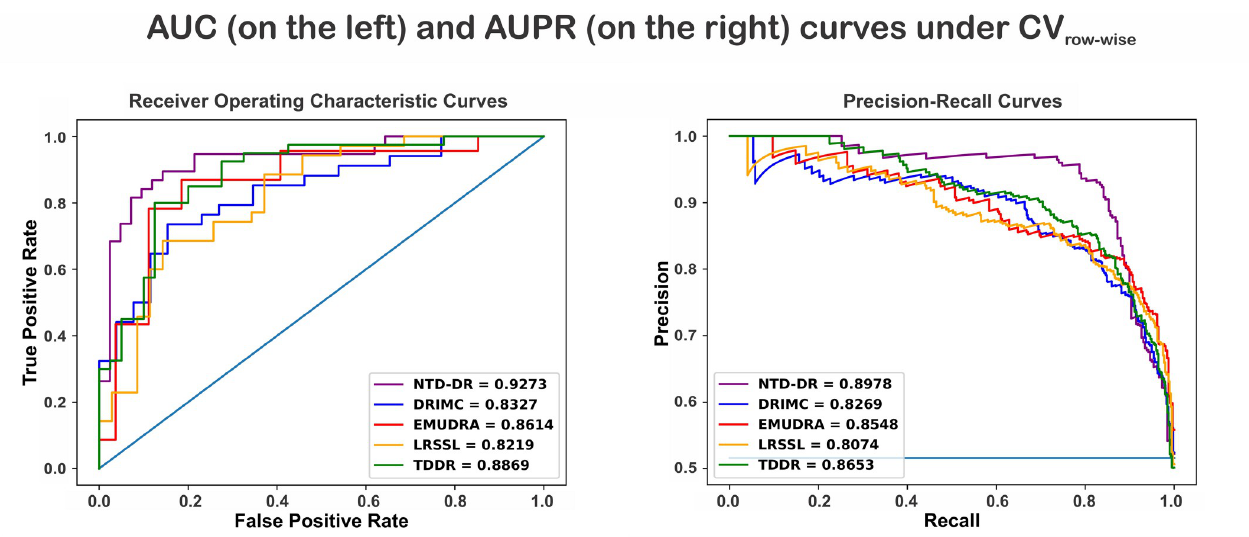
Fig 5. ROC and precision-recall curves of NTD-DR and the existing methods for scenario CVrow-wise using dataset P.